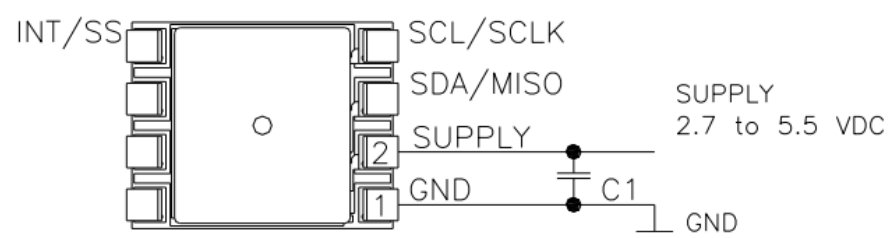
Figure 3. Pressure sensor internal block diagram [33].